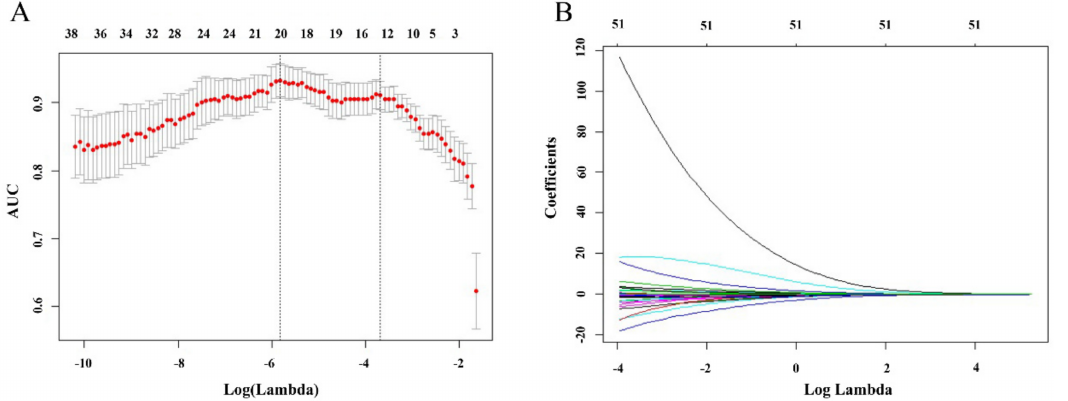
Figure 3. Feature selection using the least absolute shrinkage and selection operator (LASSO). ( A ) Tuning parameter (Lambda) selection in the LASSO model used 10-fold cross-validation via minimum criteria. ( B ) LASSO coefficient profiles of the 45 features. The optimal Lambda resulted in 12 nonzero coefficients.